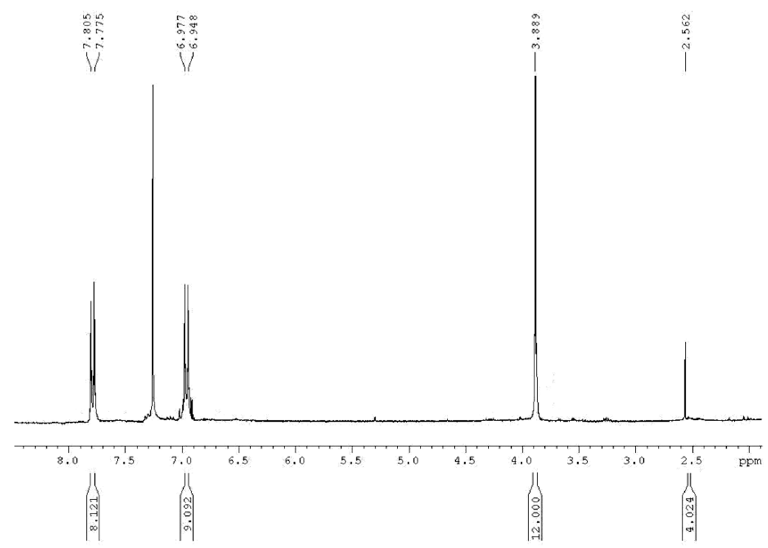
Figure 3. 1 H-NMR spectrum of 5a .